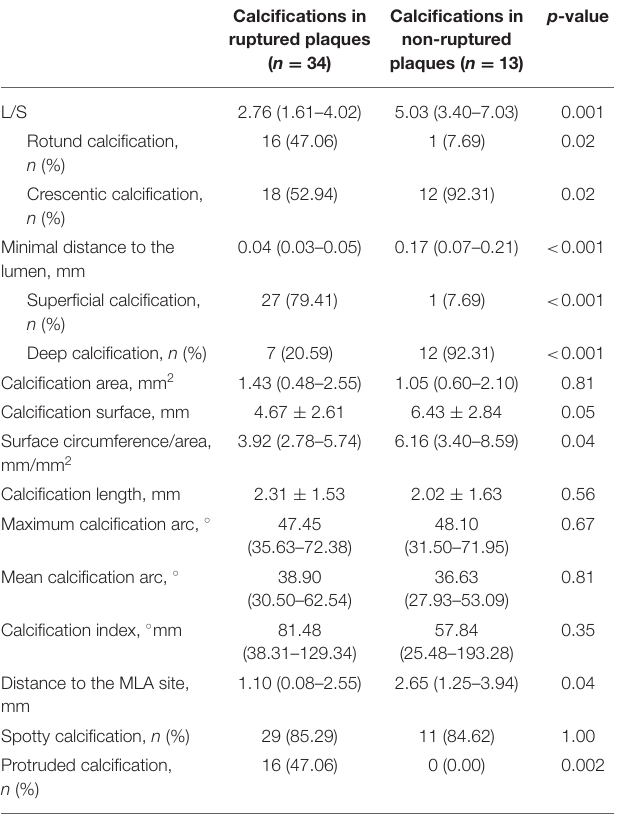
TABLE 2 | Calcification characteristics in ruptured and non-ruptured plaques.